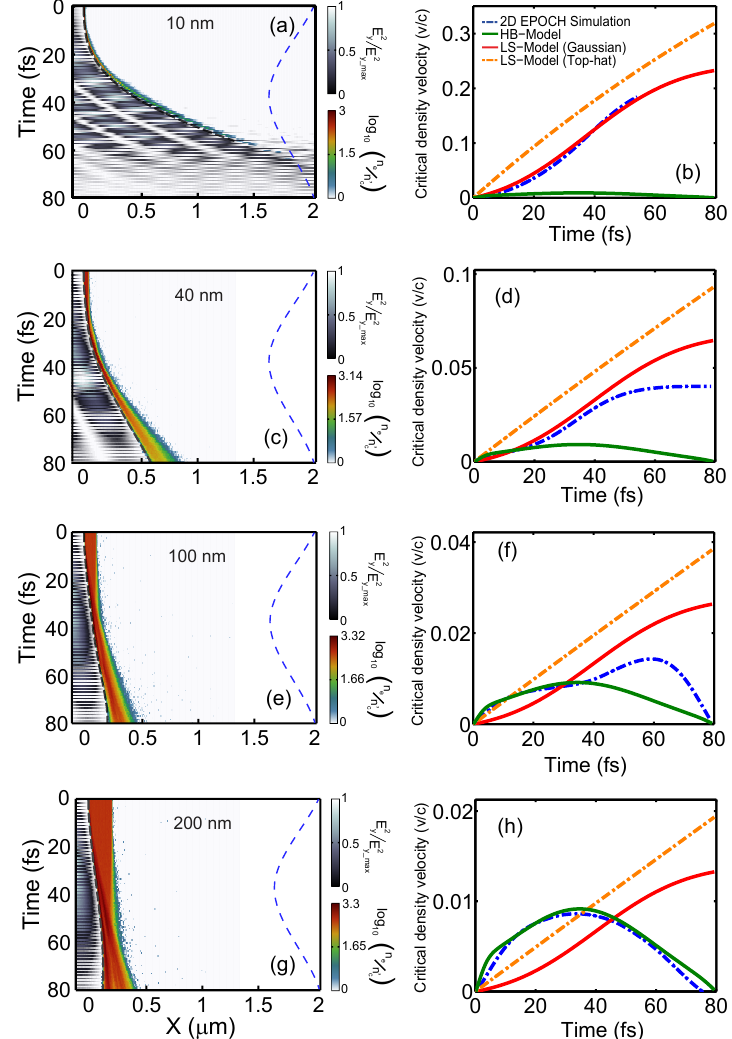
Figure 4. ( a ) 2D PIC simulation results showing the evolution of the electron density and normalized perpendicular component of the laser electric field squared, E 2 y , along the Z = 0 axis as a function of position in X and time, for l = 10 nm. The blue dashed curve is the laser pulse intensity profile as a function of time, for reference; ( b ) Relativistic critical density velocity along the Z = 0 axis as a function of time (dot-dashed blue line) from the 2D PIC simulation results. This velocity is calculated as the gradient of the black dashed line in ( a ), which delineates the relativistic critical density surface at each time; The solid green line is the time-dependent hole-boring (HB) velocity from Equation (1); The time-dependent LS velocity using a top-hat and a Gaussian laser pulse temporal profiles are shown as the dot-dash orange and solid red lines, respectively, as calculated using Equation (4). All results correspond to l = 10 nm. Corresponding plots for: ( c , d ) l = 40 nm; ( e , f ) l = 100 nm; and ( g , h ) l = 200